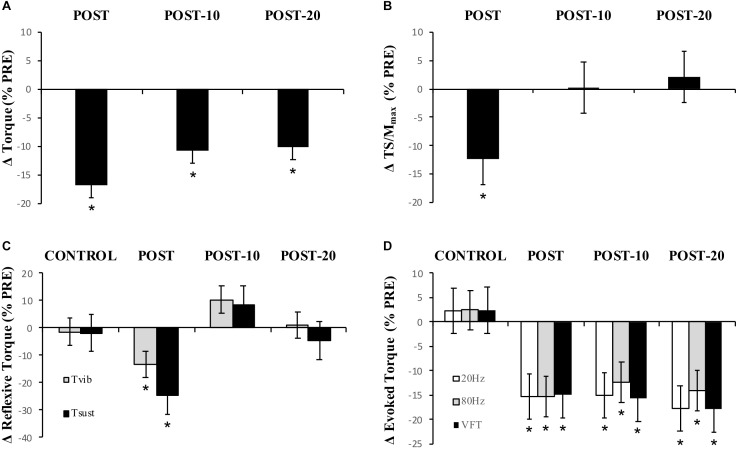
Experiment 2, changes in torque, EMG, reflexive torque, and tetanic torque measured from before to immediately (POST), 10 min (POST-10) and 20 min (POST-20) post-exercise. (A) MVC torque, (B) triceps surae EMG normalized to M-wave (TS/Mmax), (C) mean torque after the fifth (last) stimulation during vibration (Tvib) and self-sustained torque (Tsust) measured 500 ms after vibration cessation, (D) peak torque during 20-Hz, 80-Hz, and VFT trains of electrical stimulation. ∗Significantly different from PRE, p < 0.05.